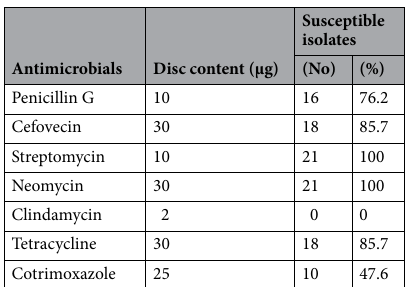
Table 3. Susceptibilities of Gordonia species mastitis isolates (n = 21) to antimicrobial agents.